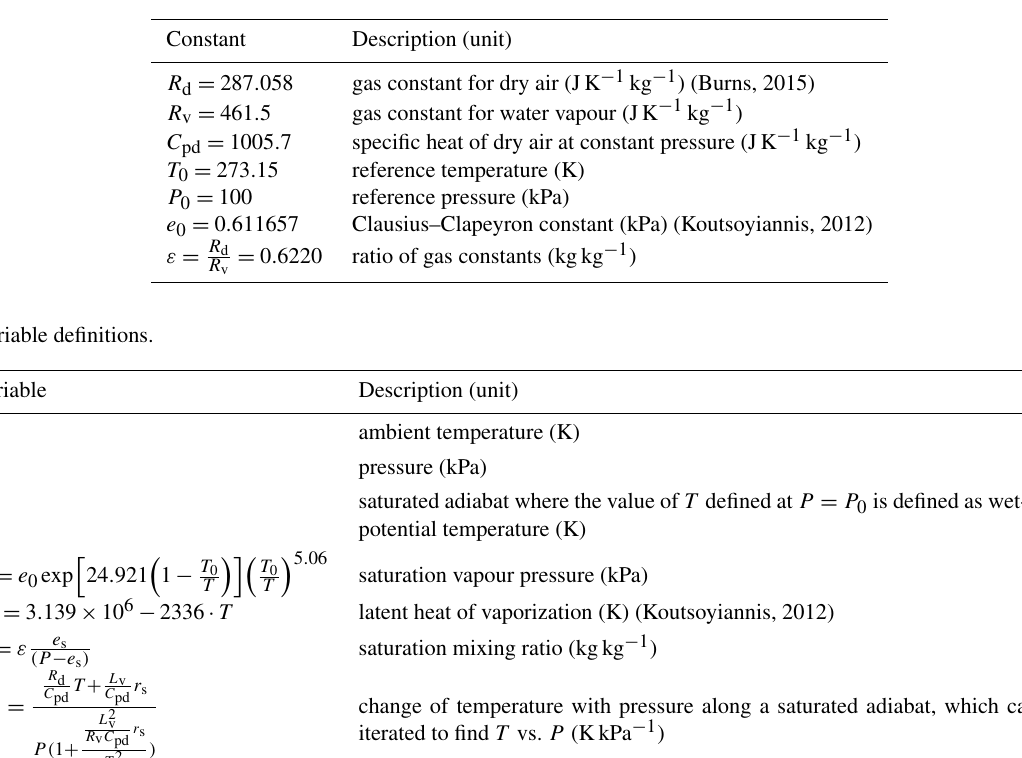
Table 1. Table of constants.